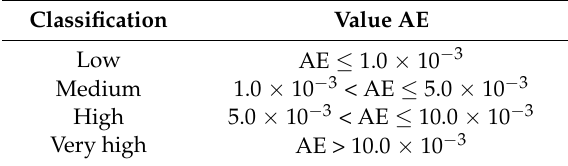
Table 2. Classification of antiradical efficiency (AE) for antioxidant compound.